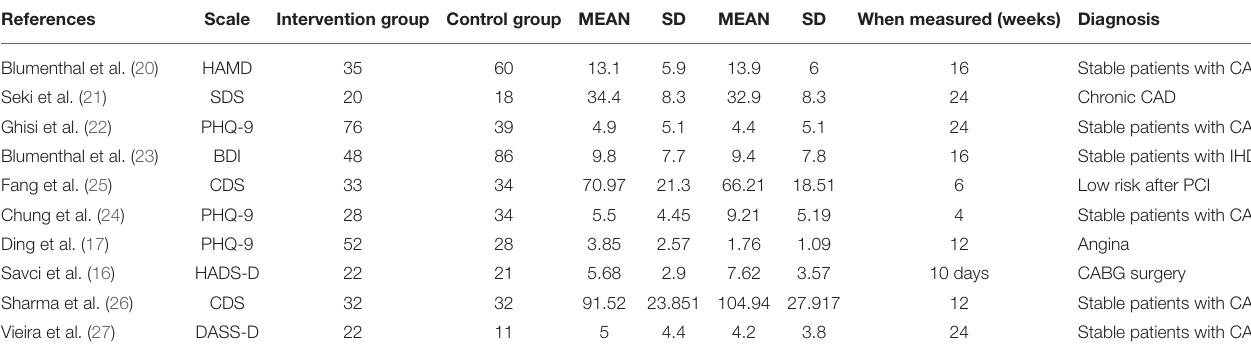
TABLE 4 | Baseline of depression included in the